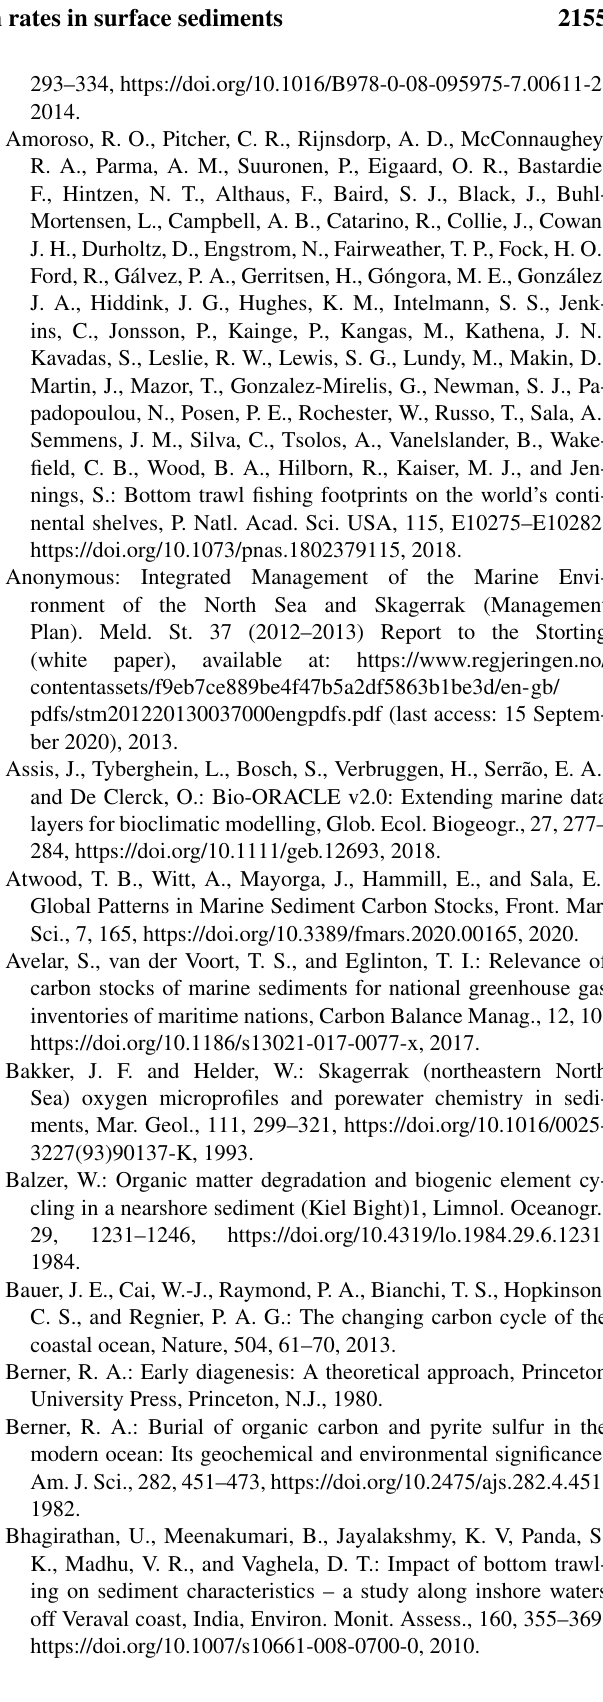
plements. Supplementary Data Table 1: linear sedimentation rates. Supplementary Data Table 2: organic carbon